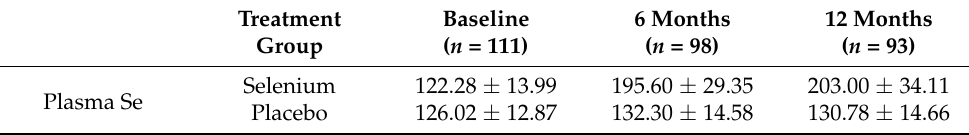
Table 2. Plasma Selenium Levels at baseline and 6 and 12 months by study arm. Treatment Baseline Group ( n = 111) Plasma